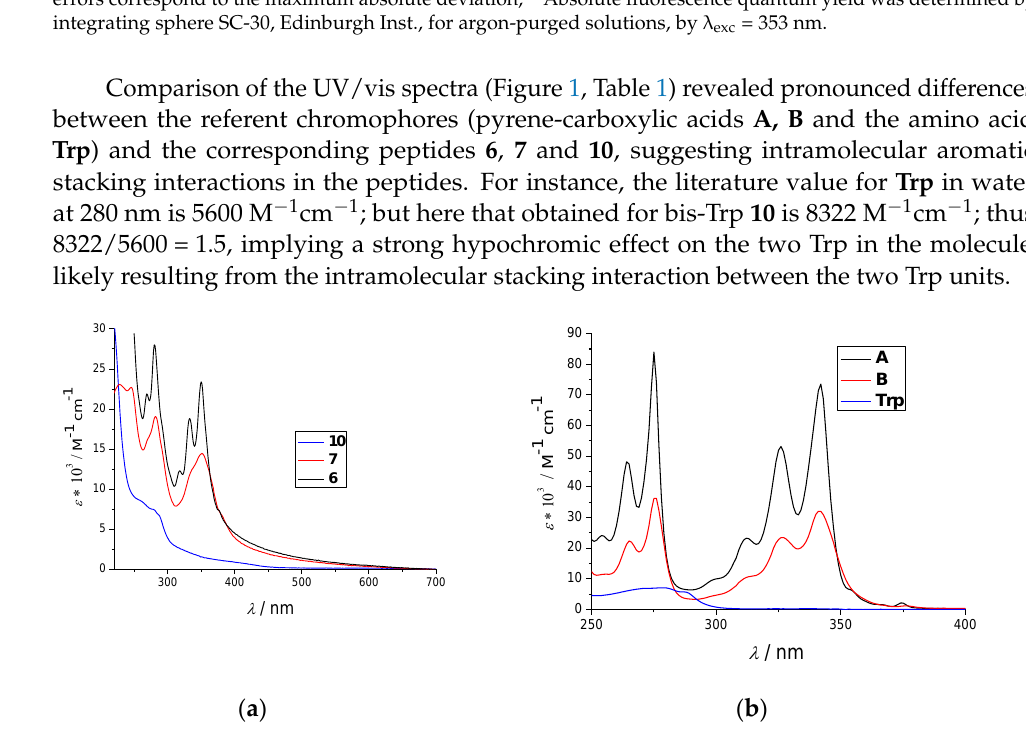
Figure 1. ( a ) UV/Vis spectra of studied peptides 6 , 7 and 10 in water (0.1% DMSO); ( b ) UV/Vis spectra of referent compounds 1-pyrenebutyric acid ( A ) and pyrenecarboxylic acid ( B ) and tryptophan ( Trp ) in water.